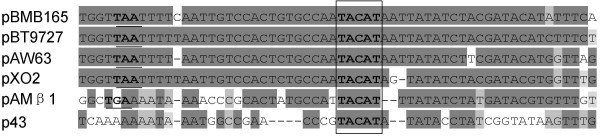
Alignment of the origin of replication in pBMB165, pBT9727, pAW63, pXO2, pAMβ1 and p43. The shaded letters indicate identical nucleotides. The box highlights a conserved replication initiation site 'TACAT'. The stop codons of the rep genes are underlined.